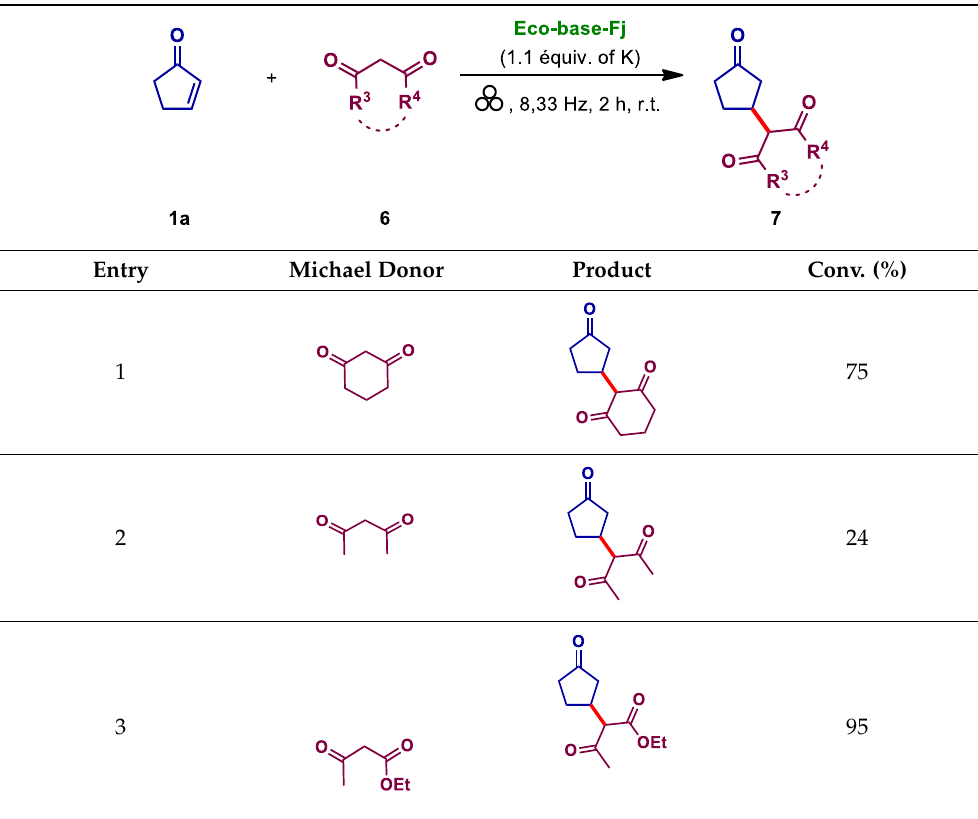
Table 7. Variation of Michael Table 7. Variation of Michael donors. Table 7. Variation of Michael donors. Table 7. Variation of Michael donors. Table 7. Variation of Michael donors. Table 7. Variation of Michael donors. Table 7. Variation of Michael donors. Table 7. Variation of Michael donors.